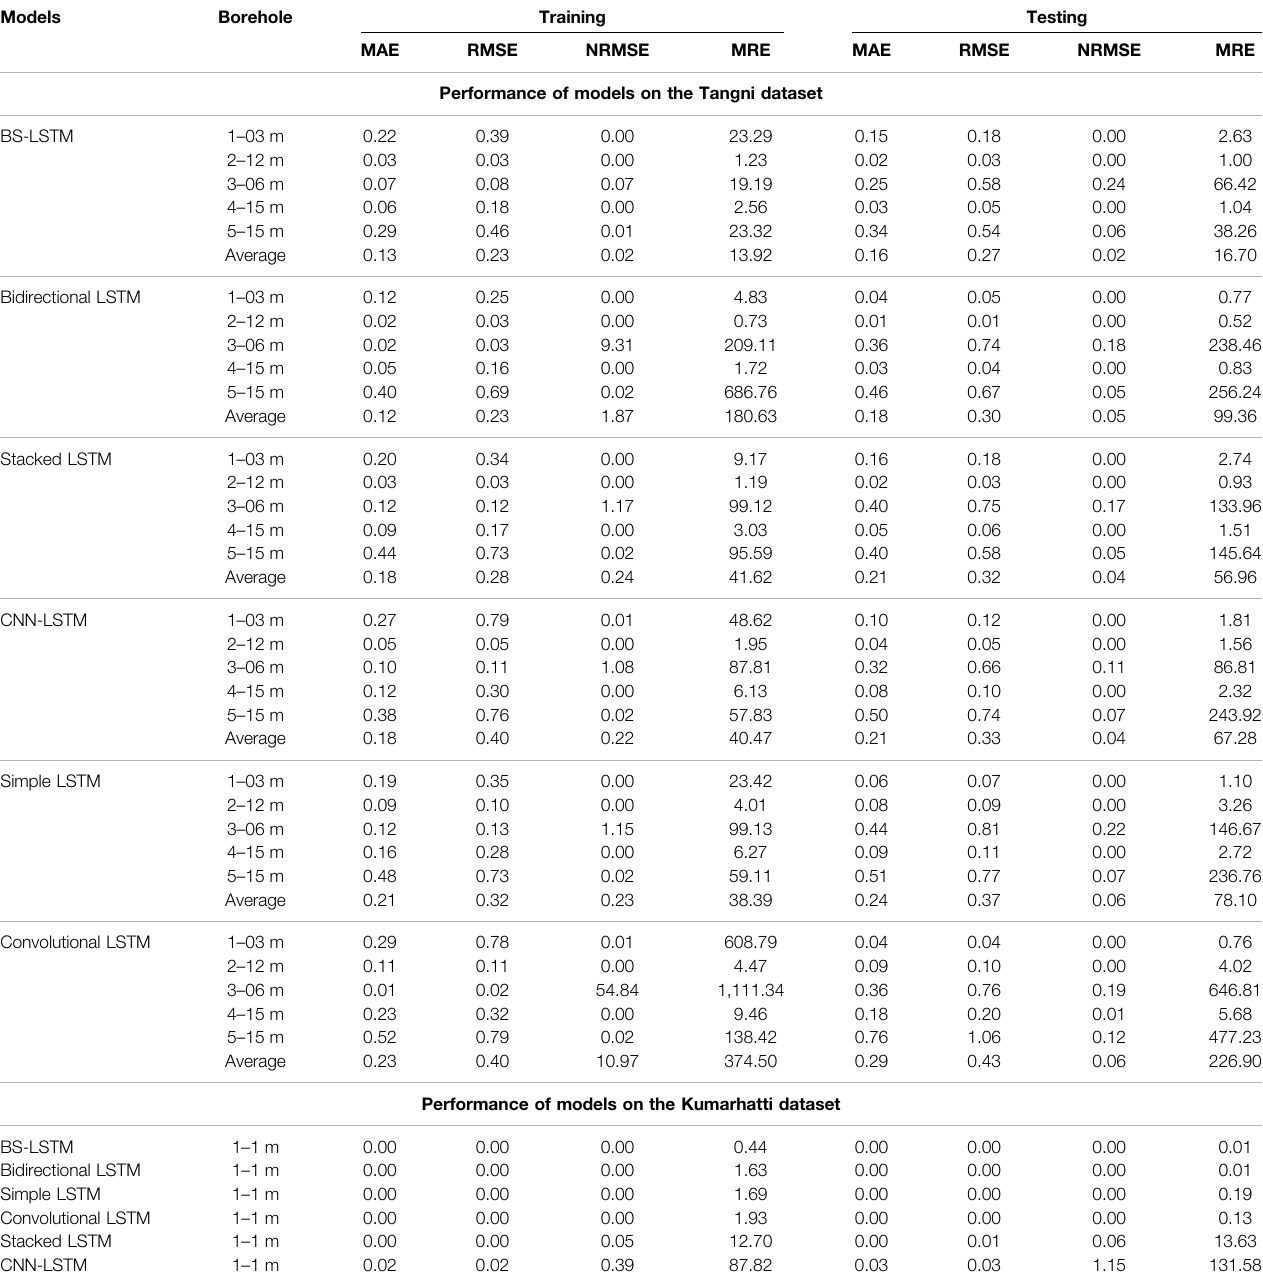
TABLE 3 | Errors of various models in the training and testing dataset.